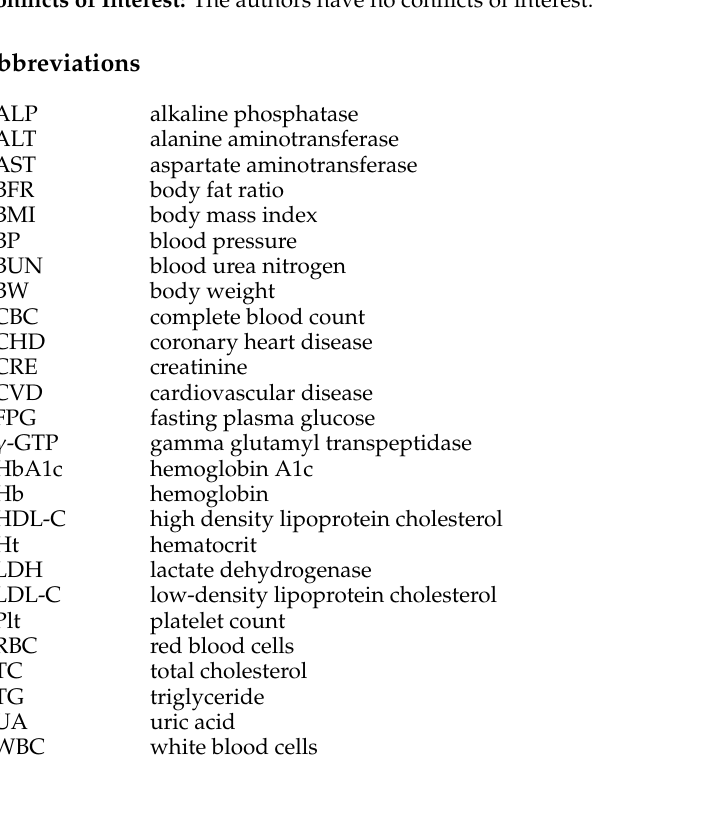
Figure S1: The correlation between the change in the logarithmically transformed TG values and BMI from baseline to week